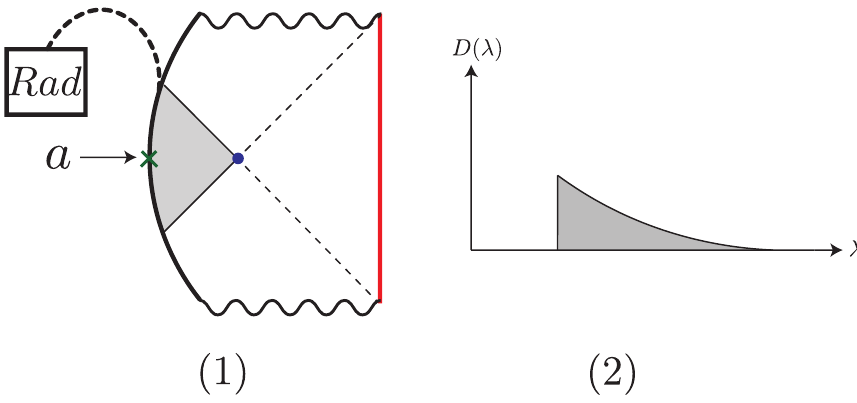
Figure 1 . (1) The Lorentzian description of the states we consider in the PSSY Model, a JT gravity black hole with an ETW brane. The ETW brane carries k flavor indices that are entangled (dashed lines) with the radiation system labelled Rad . There are additional indices (labelled a ) that span the code subspace of bulk states we consider. The extremal surface is denoted in purple and the island that dominates after the Page time is coloured gray. (2) The spectrum of the boundary density matrix ρ post Page time is a cutoff thermal spectrum without any zero eigenvalues when Rad the black hole is in the canonical ensemble. Thus, the boundary relative entropy is finite while the bulk relative entropy is infinite for distinct pure